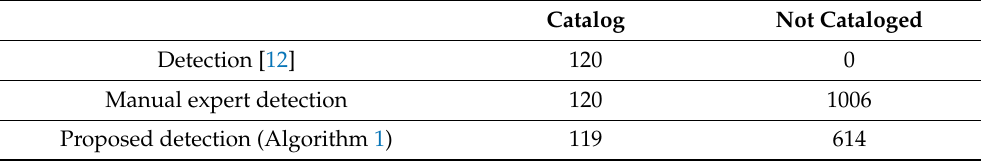
Table 2. Continuous detection result verification for the selected